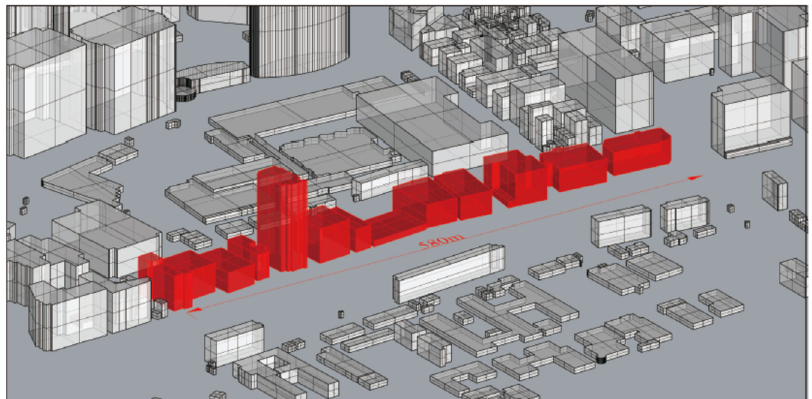
Figure 2. “Existing buildings” with surrounding buildings in Shinagawa area, Tokyo. Red colored buildings were analyzed as exiting buildings (scenario zero). It is noted that there is a canal in front of the existing buildings.